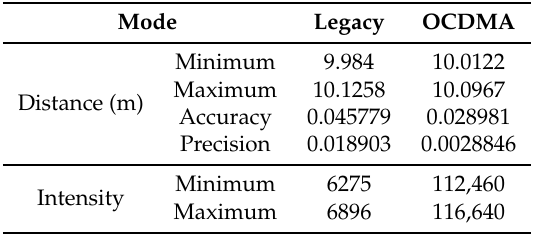
Table 4. Summary of the distance and intensity measurements for the white paper wall. Mode